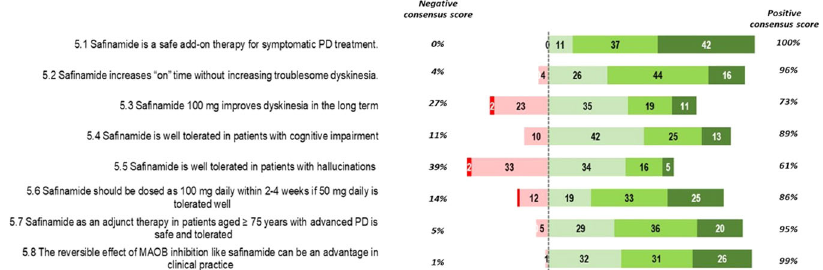
Fig. 5 Delphi questionnaire results: topic 5 “ Safety of Sa fi namide ” . Numbers in the colored bars are the total number of votes received for each level of disagreement/agreement (1, extremely disagree; 2, disagree; 3, agree; 4, mostly agree; and 5, extremely agree). The “ negative consensus score ” and the “ positive consensus score3 are percentage.